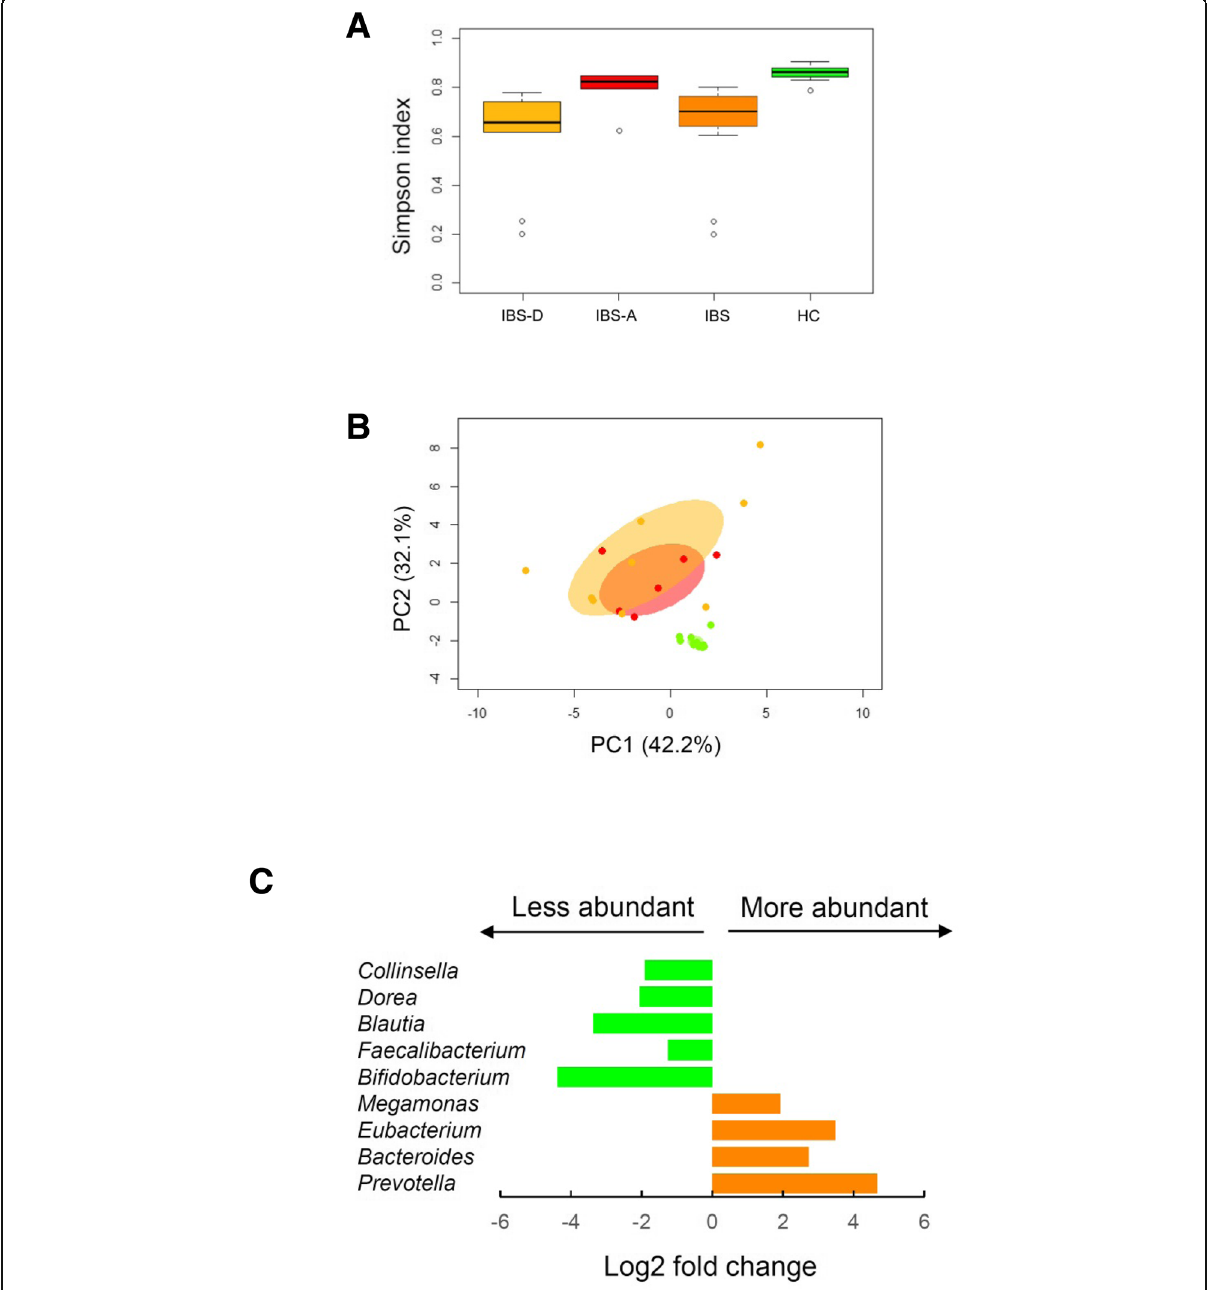
Fig. 4 Gut microbiota signatures in IBS. a Box plots showing the distribution of Simpson diversity values in IBS patients (IBS-A, red; IBS-D, orange; IBS-C, black) and healthy controls (HC, green). A significant difference between IBS patients and HC was found (Wilcoxon test, P = 9 × 10 − 6 ). b Principal component analysis of Euclidean distances between the genus-level intestinal microbial profiles (same color code as in A). Ellipses include 99% confidence area based on the standard error of the weighted average of sample coordinates. A significant separation between IBS and HC samples was found (permutation test with pseudo-F ratios, P = 2 × 10 − 5 ). c Genus-level microbial signatures of IBS, shown as Log2-fold changes between IBS and control samples. Orange, taxa more abundant in IBS; green, taxa more abundant in HC. Wilcoxon test, P <